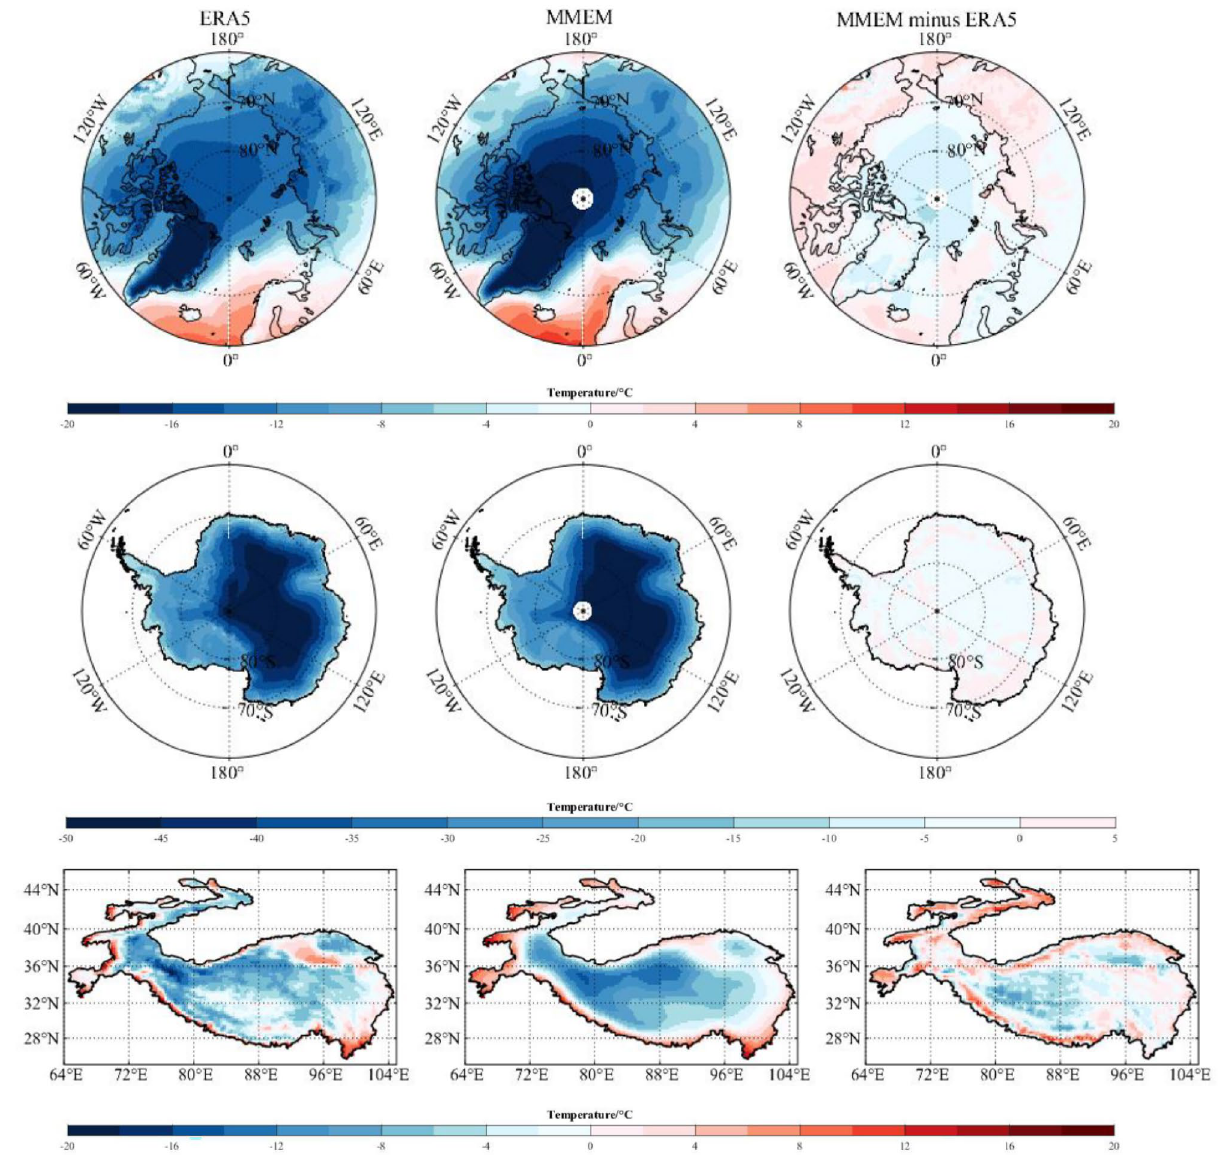
Figure 2. Spatial patterns of annual mean temperature from the ERA5 (left panel), the multi-model ensemble mean (MMEM) of the CMIP6 model simulations (center panel), and their biases (MMEM minus ERA5) (right panel) over the Arctic, Antarctica and The Third Pole during 1979–2014. The map was drawn in the software MATLAB R2018b (https:// ww2. mathw orks. cn/ produ cts/ matlab.